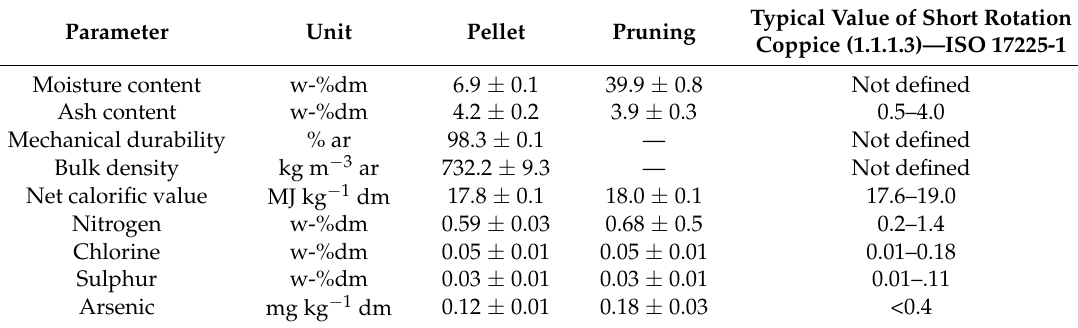
Table 9. Results of analysis for pellet and pruning with reference values typical for short rotation coppice pellet provided by the ISO 17225-1 standard.